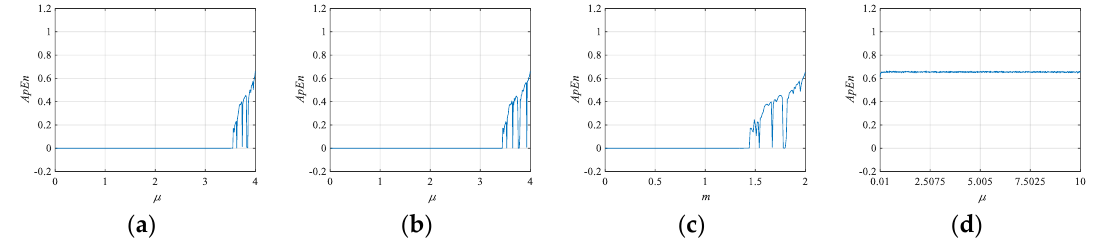
( c ) Quadratic map; ( d ) The proposed system.